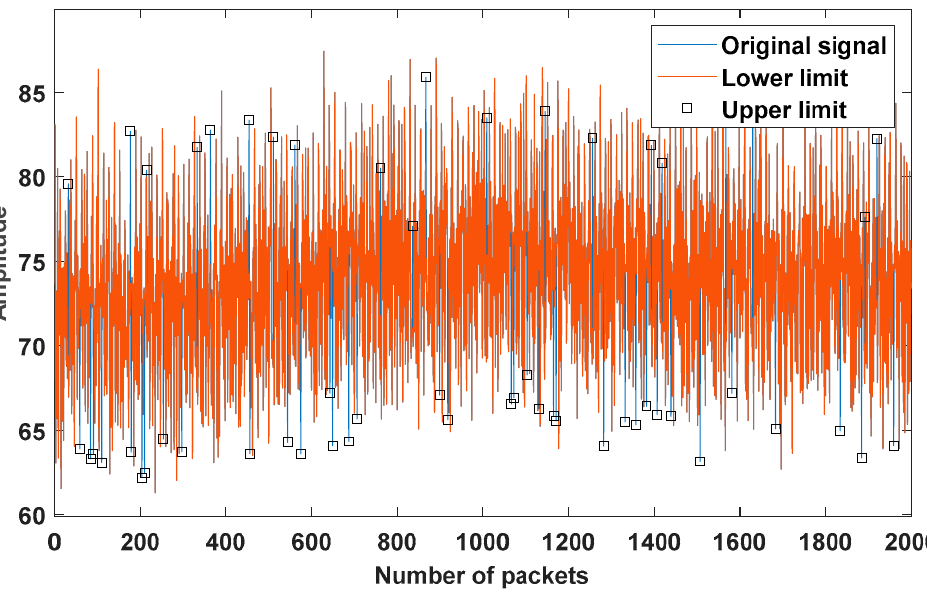
Figure 4. Outlier processing.